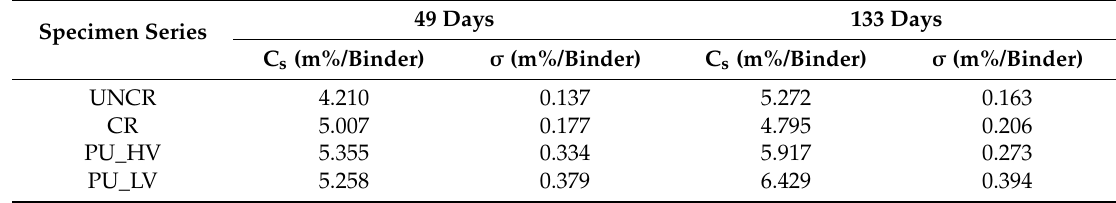
Table 5. Estimated values of C s for the different test series at exposure times of 49 and 133 days.